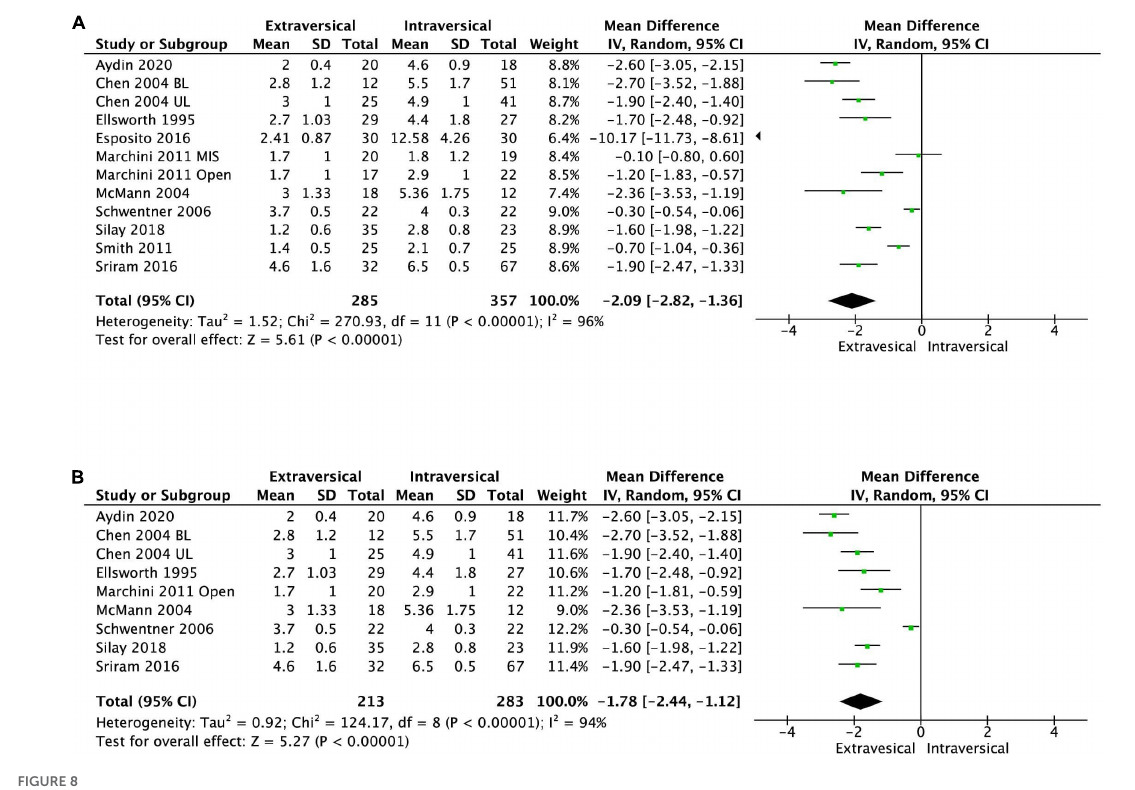
who underwent IVUR (MD − 2.09 days; 95% CI, − 2.82 to − 1.36, P < 0.00001, I 2 = 96%) ( Figure 8A